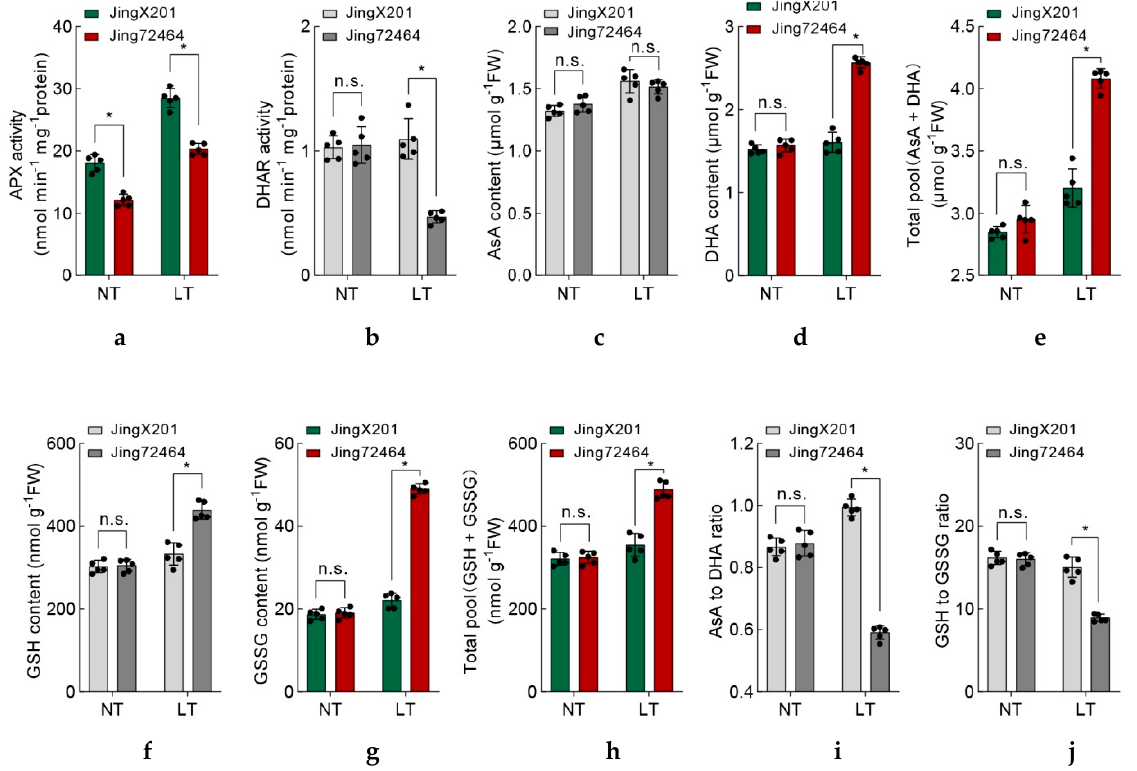
Figure 4. Enhanced GSH-AsA redox status in LT-tolerant accession Jing72464. ( a , b ) Cellular activity of ascorbate peroxidase ( a ) and dehydroascorbate reductase ( b ) in LT-sensitive inbred JingX201 and LT-tolerant inbred Jing72464 under NT and LT condition. ( c , d ) Cellular contents of AsA ( c ) and DHA ( d ). ( e ) Total AsA-DHA pool, caculated as the combination of AsA and DHA content. ( f , g ) Cellular contents of GSH ( f ) and GSSG ( g ). ( h ) Total GSH-GSSG pool, caculated as the combination of GSH and GSSG content. ( i , j ) The ratio of AsA/DHA ( i ) and GSH/GSSG ( j ). Data are mean ± s.e.m. ( n = 5). n.s. means no significance, * means p < 0.05.